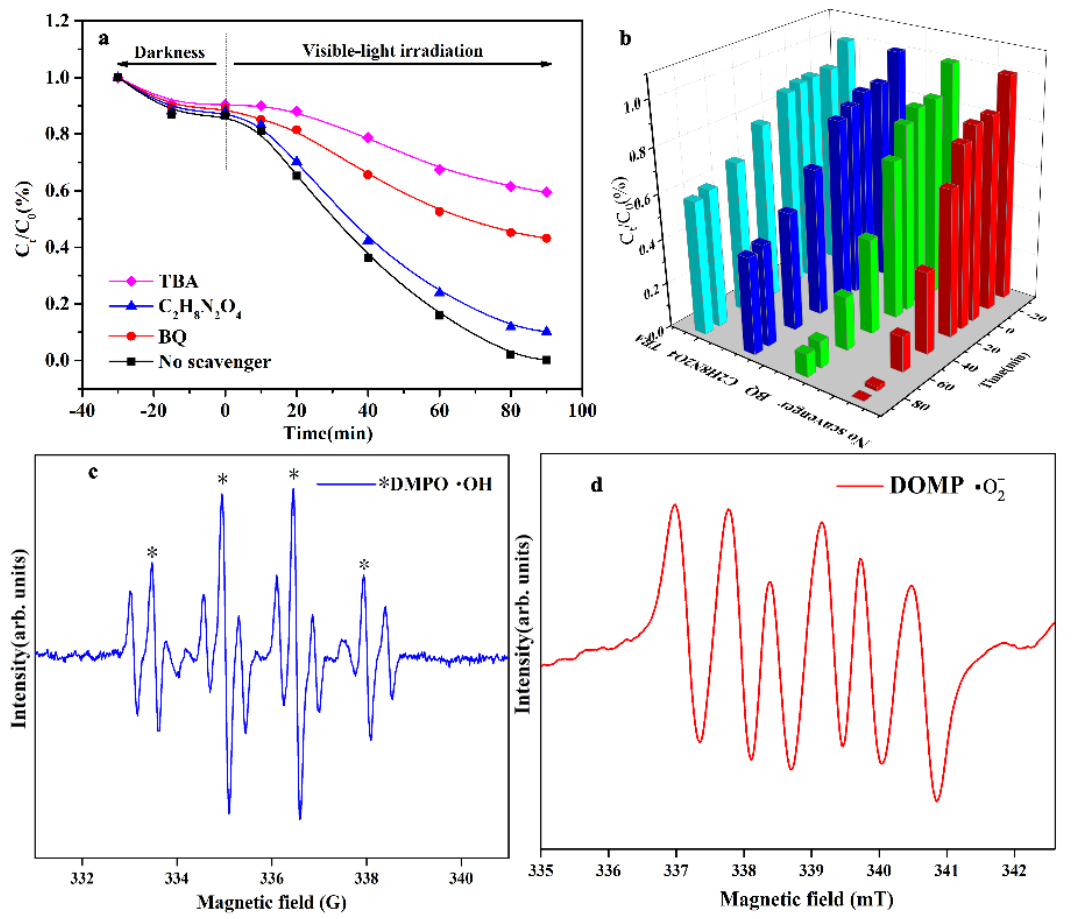
Figure 9. The 1:8 photocatalytic material system: photocatalytic efficiency of TCH with different scavengers under visible-light irradiation ( a , b ); ESR spectra of DMPO-•OH and -•O 2− under aqueous and methanol phase ( c , d ).